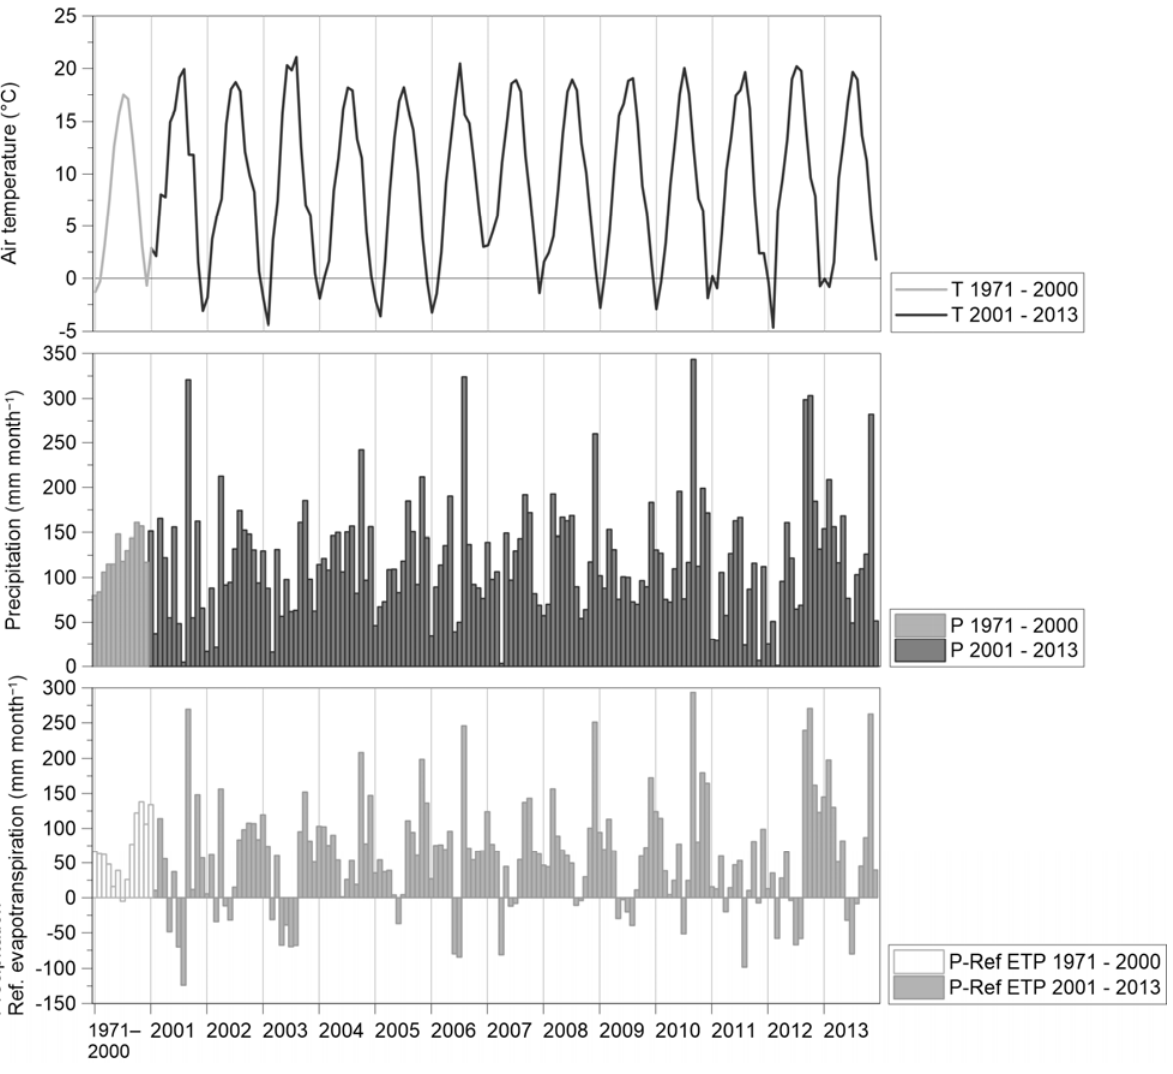
Figure 1. Mean monthly air temperature (T), precipitation (P), and difference between P and reference evapotranspiration (P—Ref ETP) at Ko č evje meteorological station from 1971 to 2000 (first column) and from 2001 to 2013.